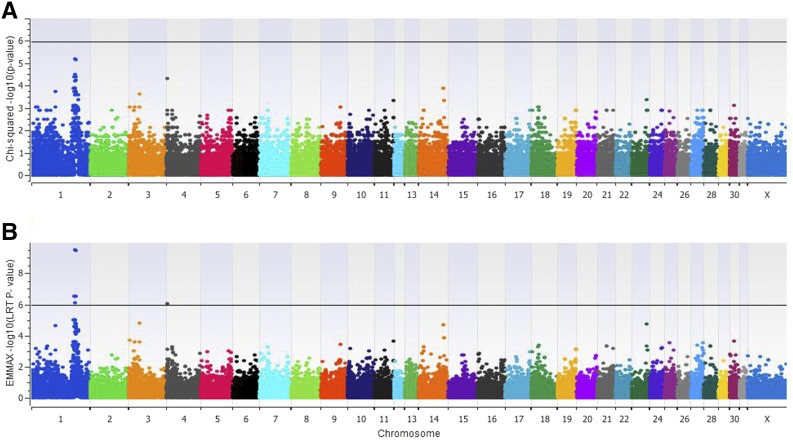
Manhattan plots. (A) Manhattan plot of χ2 association test using a recessive model. (B) Manhattan plot of single locus mixed linear model analysis for tiger-eye phenotype in horses. Shown are the output –log10
P-values calculated from the linear regression and F-test. The black line represents the threshold for strict Bonferroni level of significance (P < 1.16 × 10−6). EMMAX, Efficient Mixed-Model Association eXpedited.